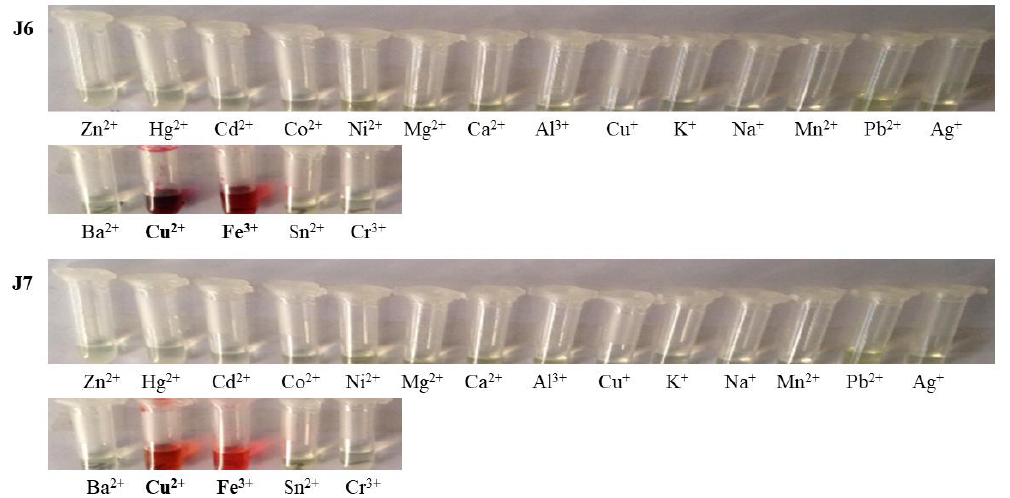
Figure 4. Visible color changes of J6 (top) and J7 (bottom) after the addition of Cu 2+